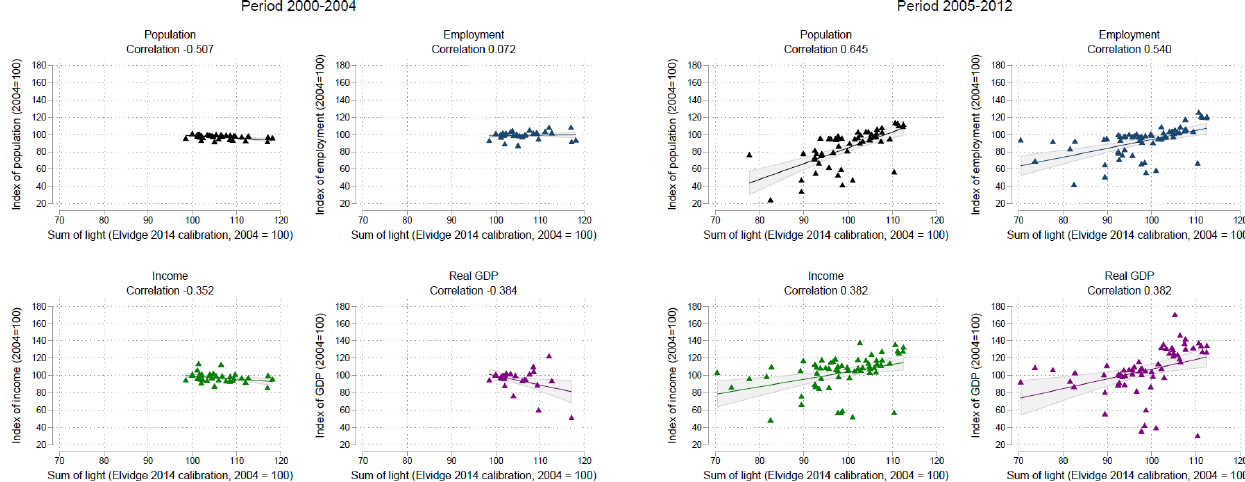
Figure 8. Indexed economic indicators and total sum of light for the eight affected counties before Katrina. Based on own calculations. Right panel: population data are for 2006–2012